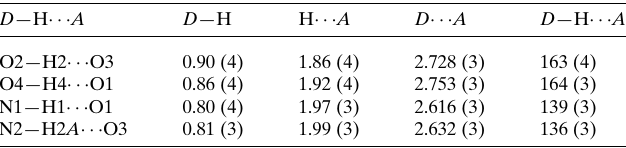
Table 1 Hydrogen-bond geometry (A˚ , (cid:2) ).